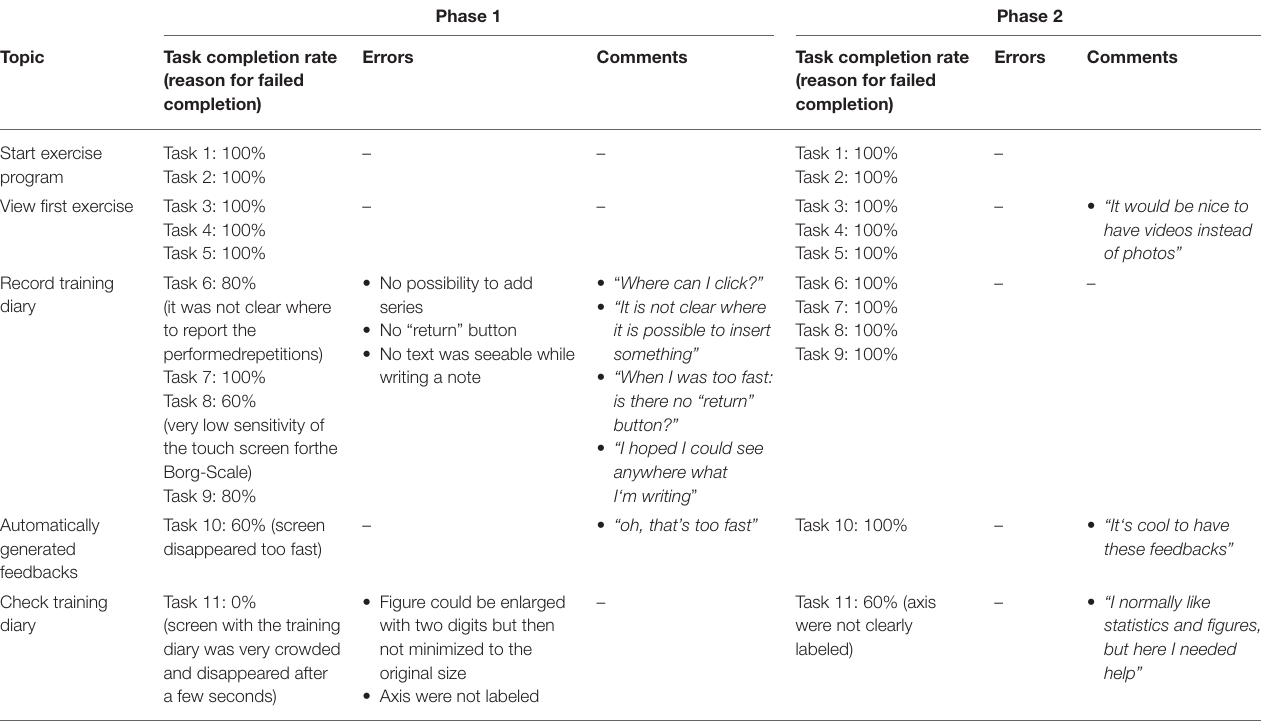
TABLE 7 | Tasks completion rate, reasons for failed completion, errors and comments of the trainees.